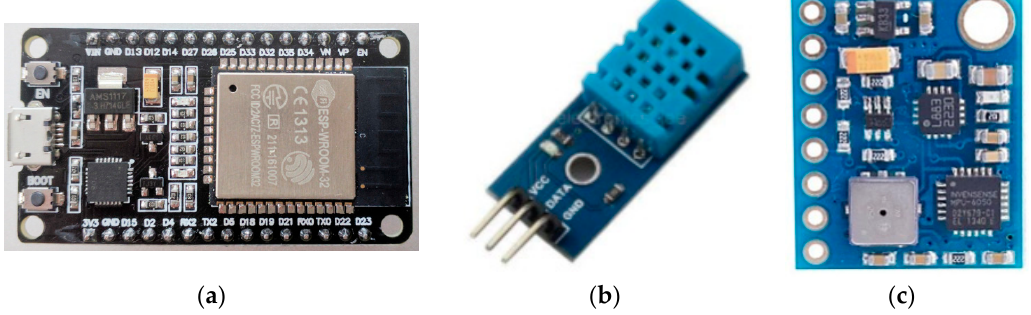
Figure 4. The module of ESP32 DEVKIT V1 [55] ( a ); the DHT11 sensor [56] ( b ); and MPU-6050 [57] ( c ).